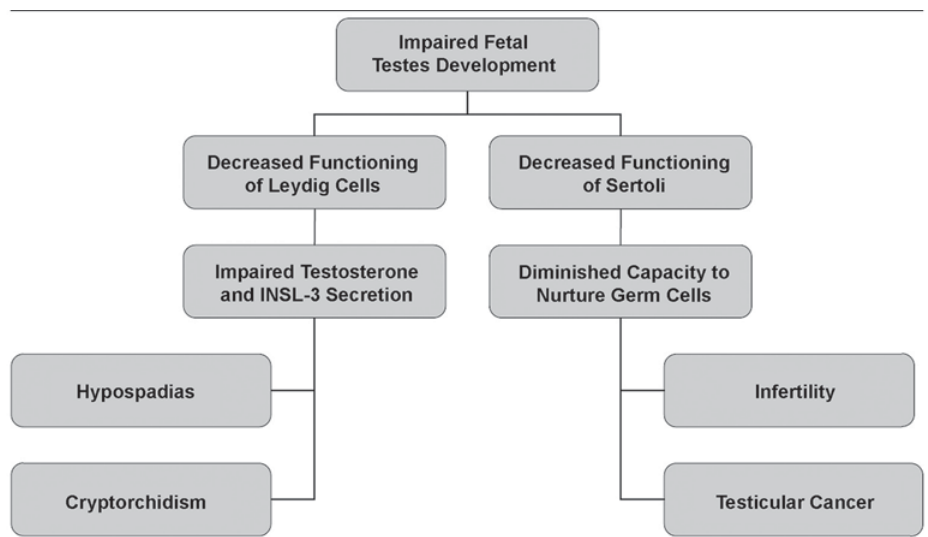
Figure 1 – Proposed mechanism leading to testicular dysgenesis. In this pathway, the key event is the impairment of testes development during fetal